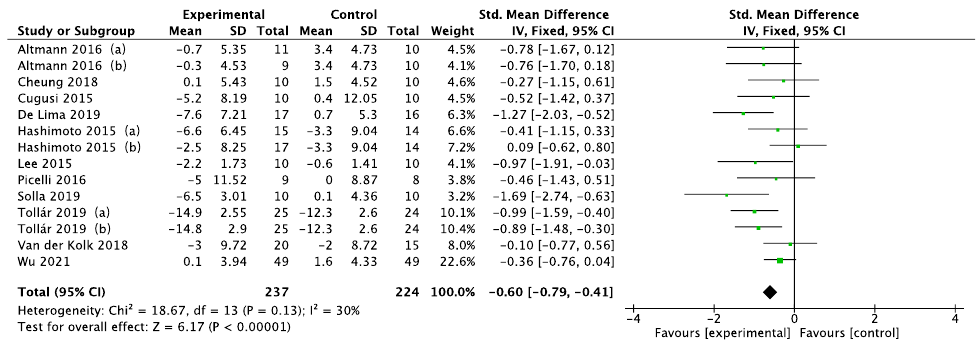
Figure 4. Forest plot of the effect of physical activity on depressive symptoms in PD patients [24,25,33–41].